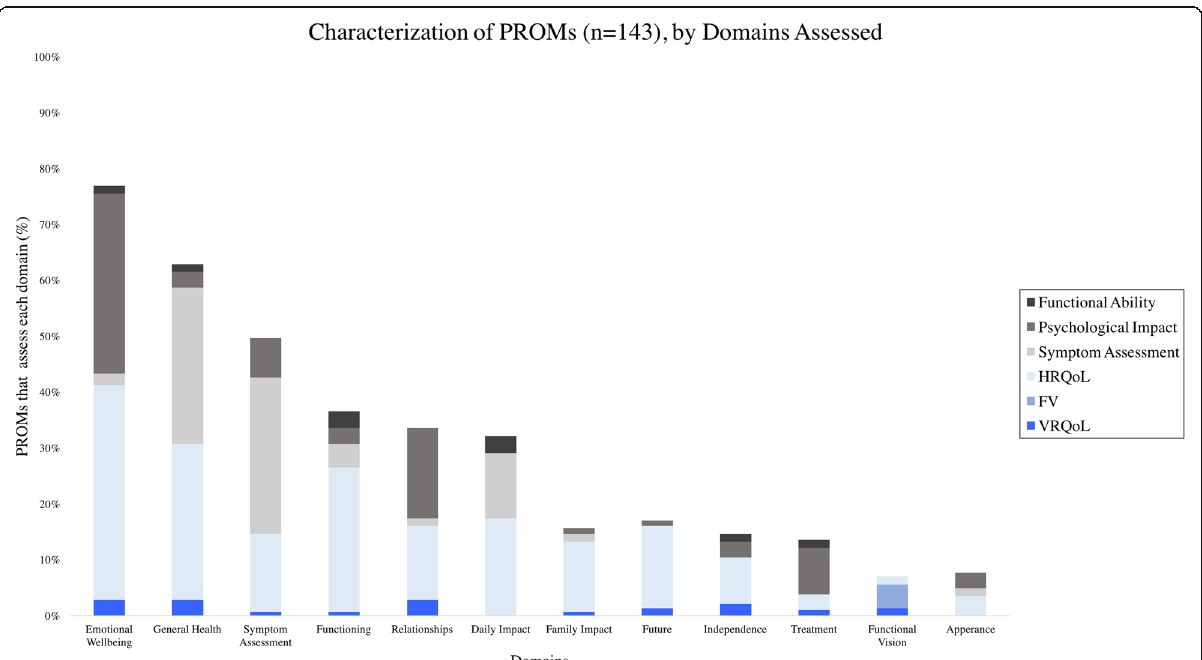
Fig. 4 Characterization of PROMs by Domain Assessed. The domains assessed by each PROM (n = 143) were identified and their frequency tabulated. Domains, shown left to right, are ordered most frequently to least frequently assessed, stratified by construct. The most frequently assessed domain was emotional well-being (110/143), followed by general health (90/143), and symptom assessment